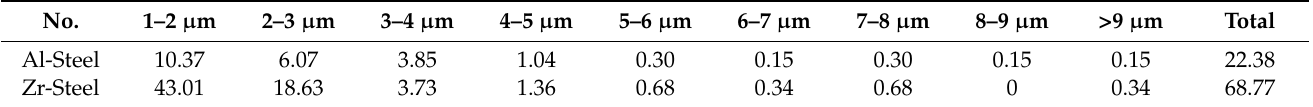
Table 5. Number of inclusions in different